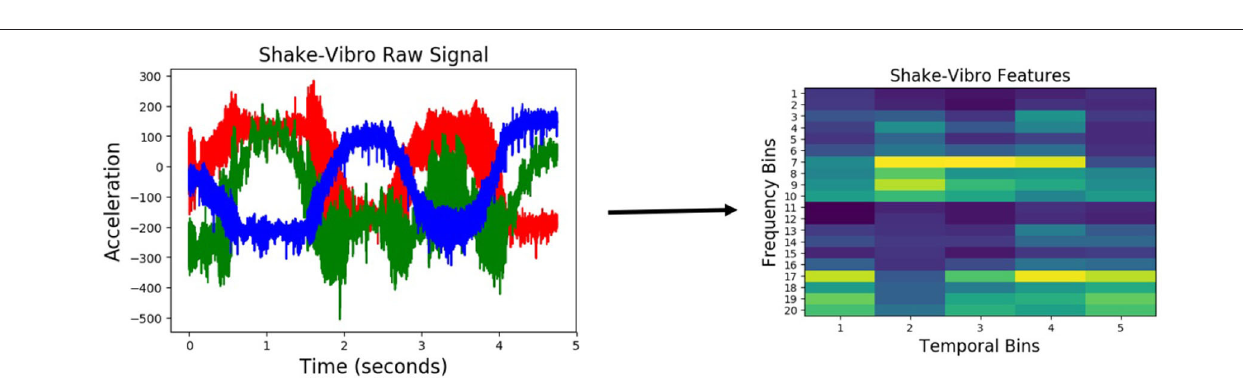
FIGURE 5 | Haptic features produced when the robot performed the shake behavior on an object from the medicine bottles category.